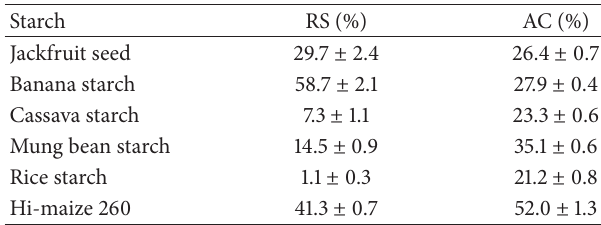
Table 1: Resistant starch and amylose contents of JFS and other native starches compared to a commercial